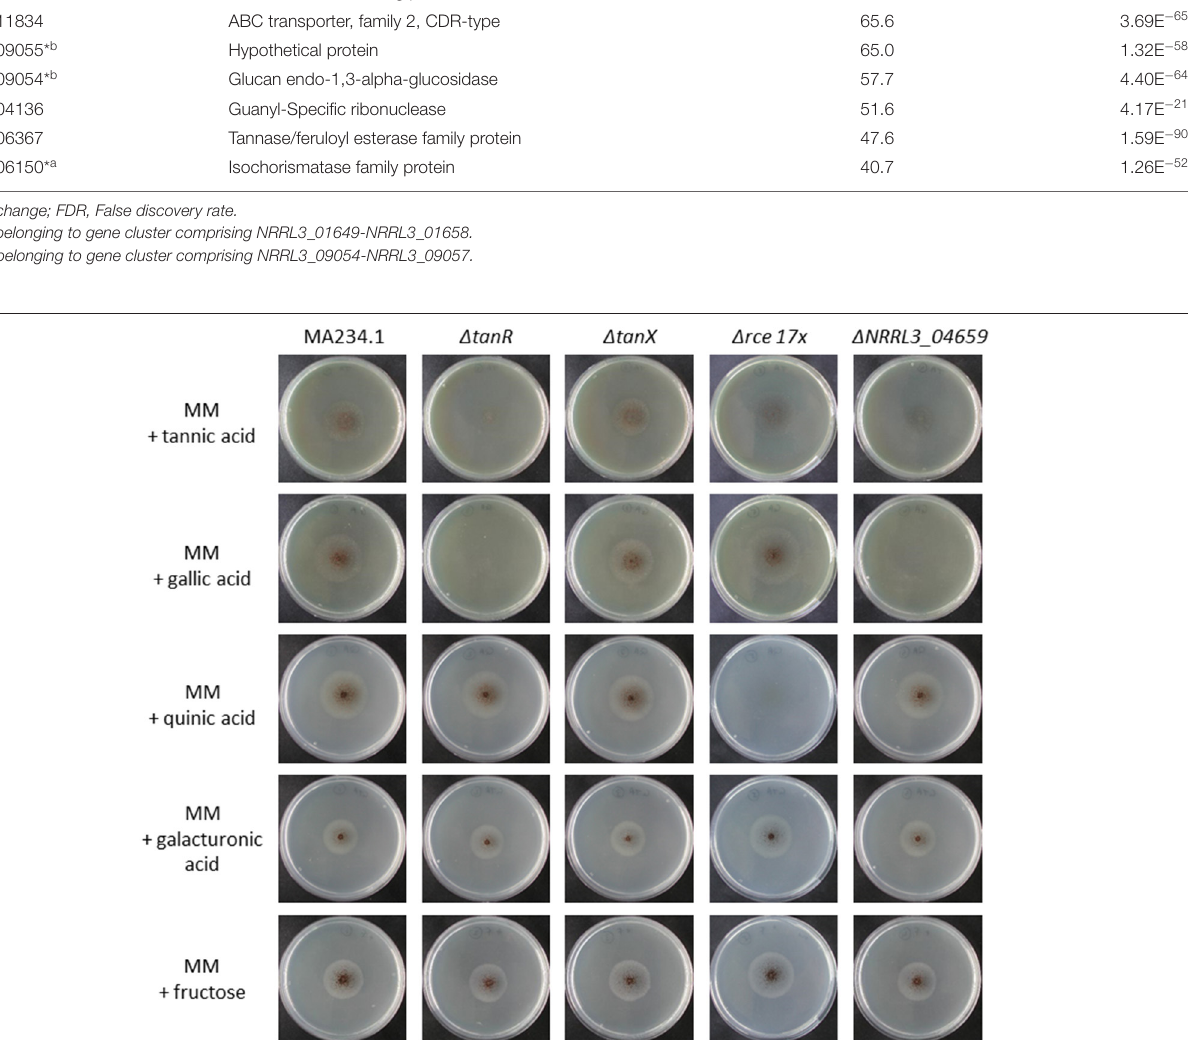
Frontiers in Fungal Biology |